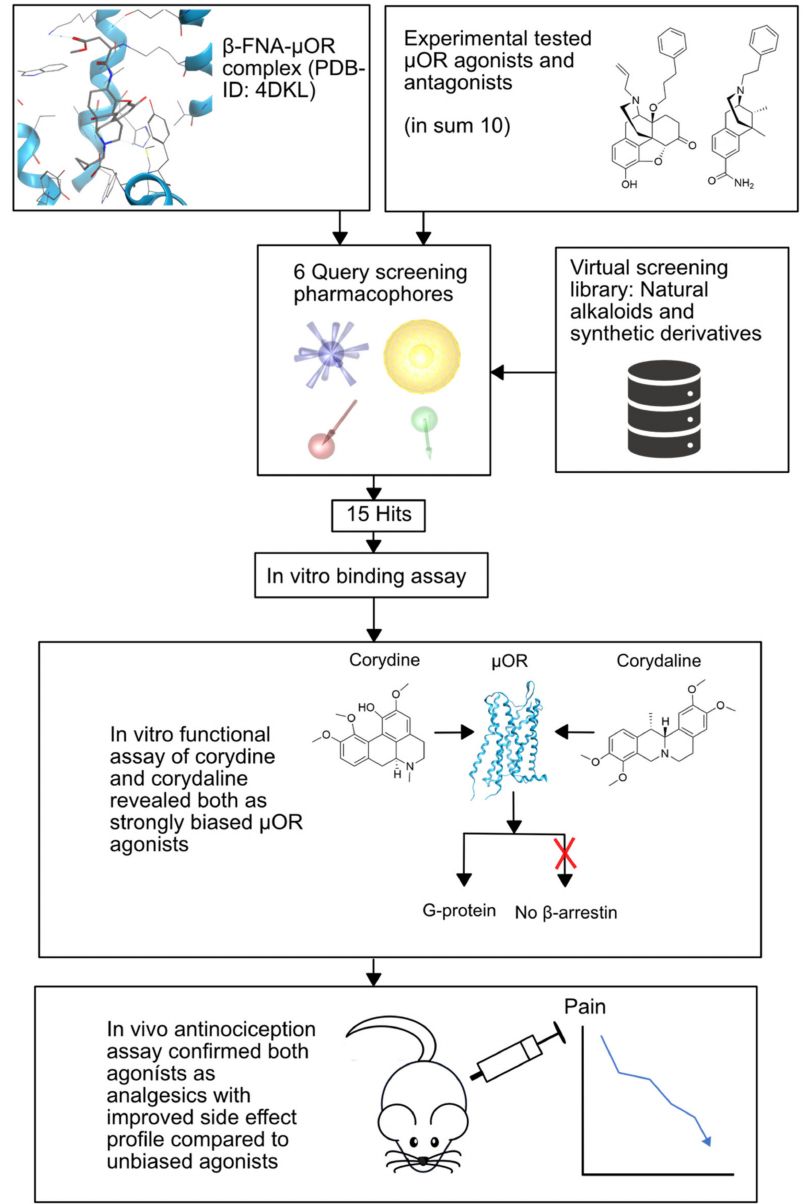
Figure 3. VS workflow carried out by Kaserer et al.